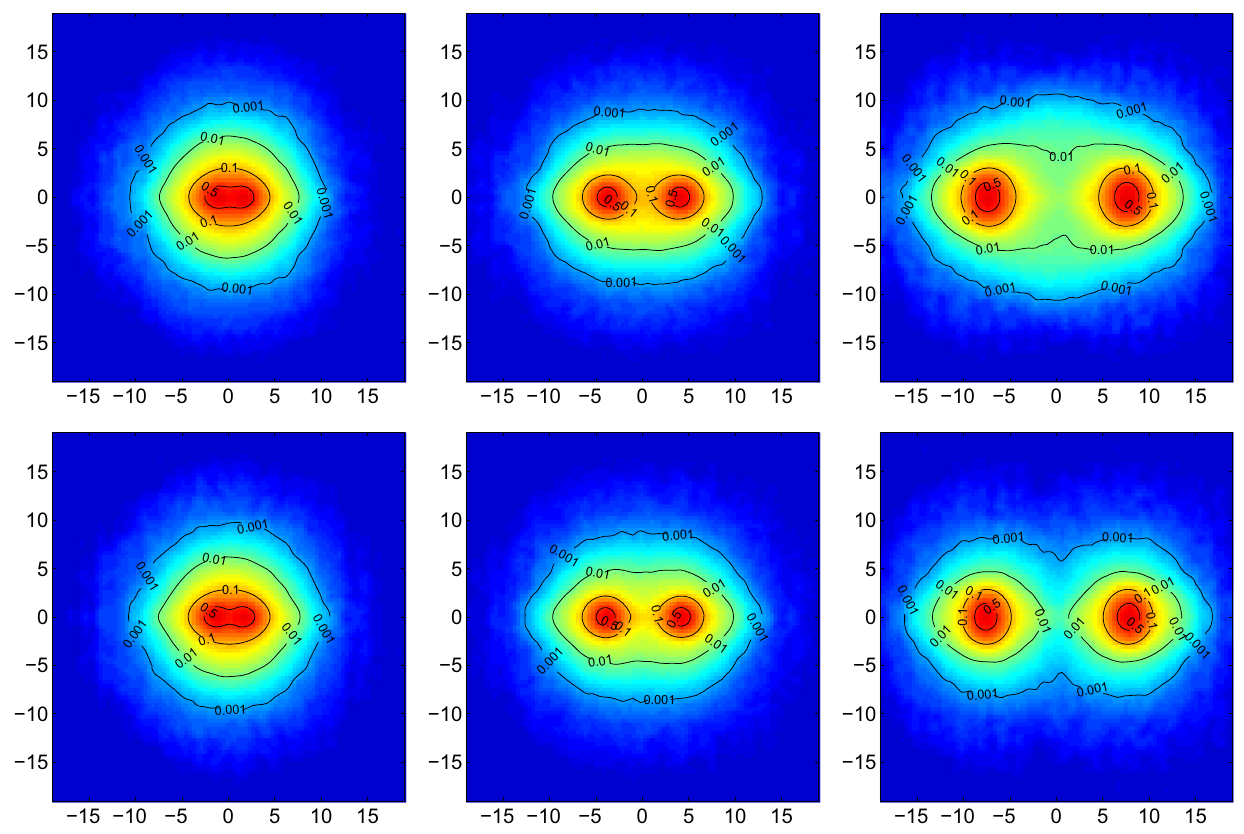
Fig. 7 The difference in the post-collision mass distributions of fast symmetric galaxy cluster collisions with weakly scattering DM and k = 4 . 0. Top row shows the post-collision mass distribution with weakly scattering DM and the bottom row shows the same for stan- dard CDM. Left panels show the mass distributions at early separation